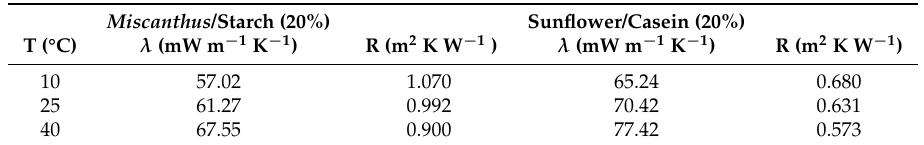
Table 3. Thermal conductivity λ and thermal resistance R , according to temperature T , for composites panels with 20% binder content